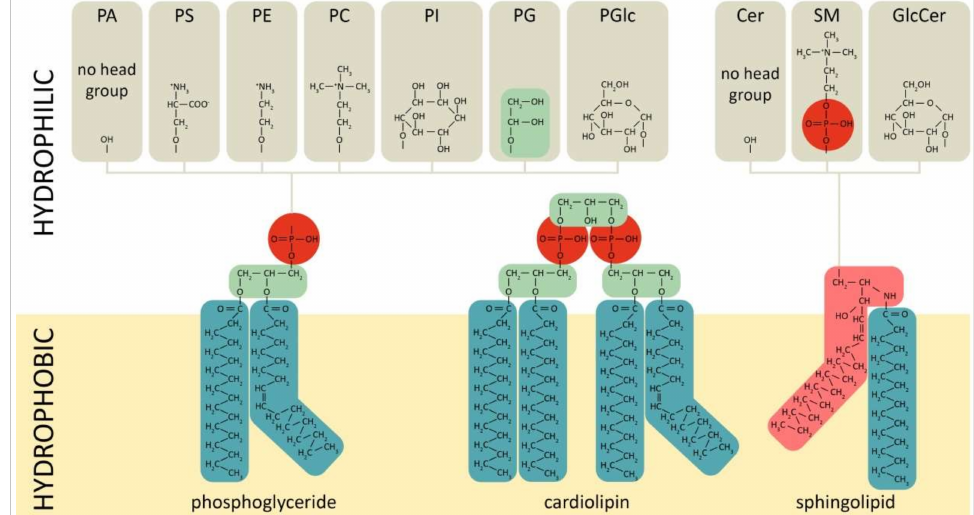
Figure 1. Chemical structures of main phospholipid types. Red—phosphate group, green—glycerol, pink—sphingosine, dark—green-fatty acids. PC/E/S/I/G/Glc—phosphatidylcholine/-ethanolamine/-serine/-inositol/-glycerol/-glucoside, PA—phosphatidic acid, SM—sphingomyelin,